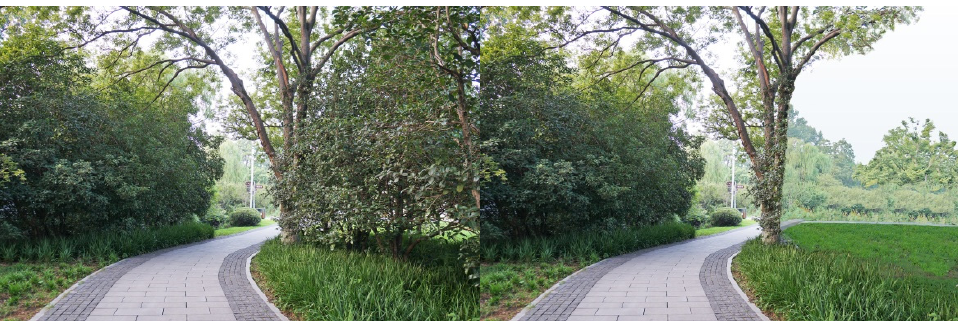
Figure 14. Visual accessibility (“screening” height shrubs at the right were removed, to reveal open view beyond).